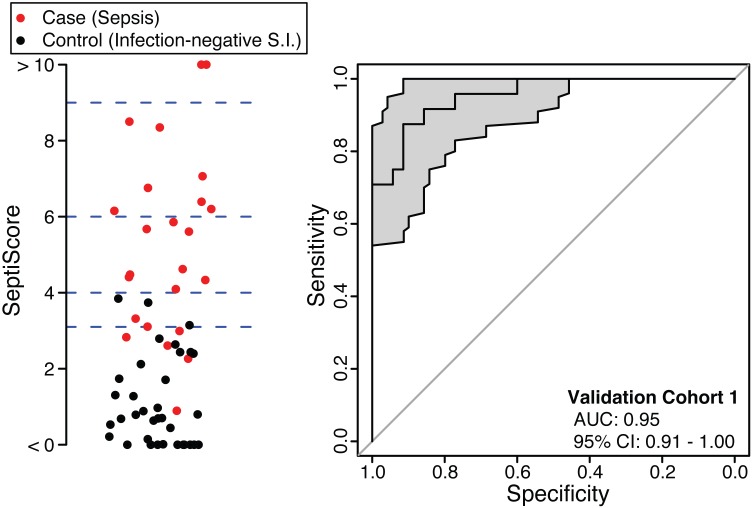
Performance of SeptiCyte Lab in validation cohort 1.Left: Scatterplot of SeptiScores for 24 cases (sepsis; red) versus 35 controls (infection-negative systemic inflammation [S.I.]; black). The blue dashed lines denote SeptiScore values of 3.1, 4.0, 6.0, and 9.0, which are used for subsequent calculations. Right: ROC curve. The grey shading denotes the 95% confidence area.